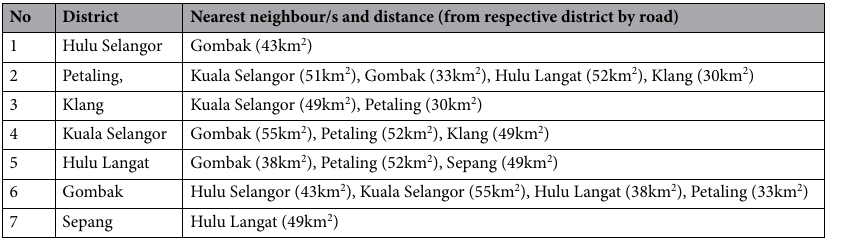
Table 1. Districts and their respective neighbouring(s)